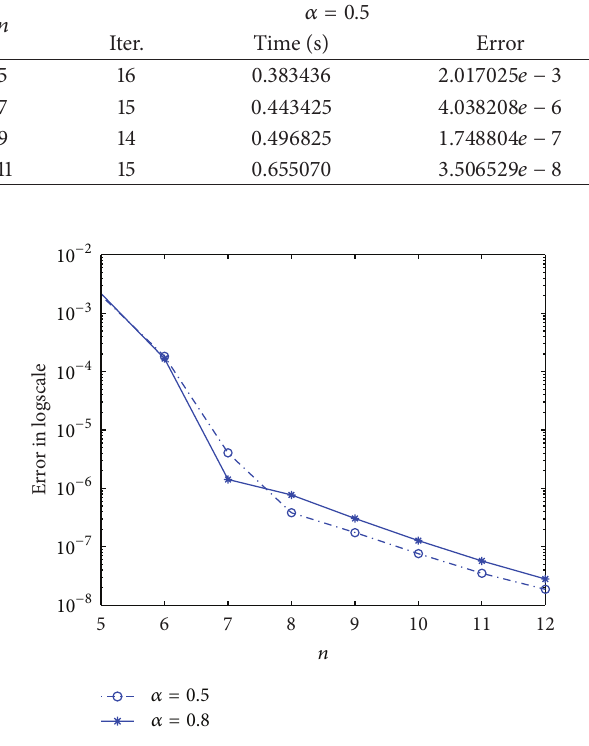
Figure 2: The errors for different 𝑛 and 𝛼 in Example